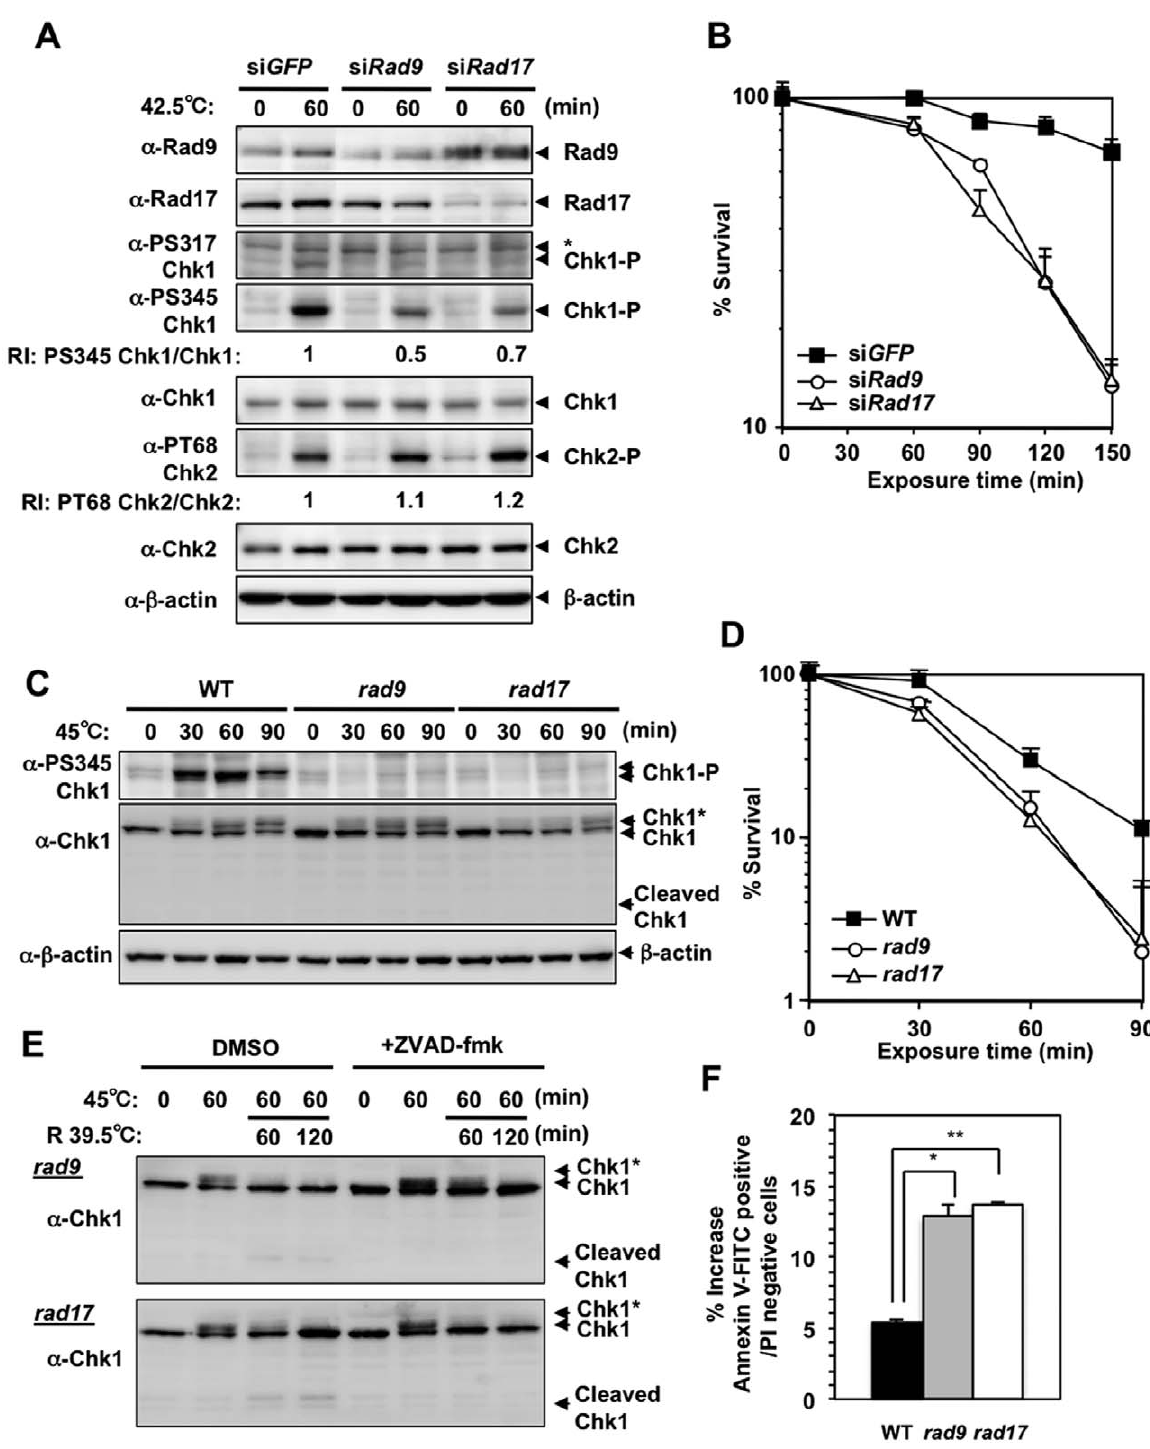
Figure 2. Rad9- or Rad17-deficiency inhibited heat-induced Chk1 phosphorylation at Ser345 and enhanced heat cytotoxicity. A. Western blot. HeLa cells were transfected with siRNA for GFP, Rad9 or Rad17 and cultured at 42.5 u C for 60 minutes. Non-specific bands were indicated as *. RI: relative intensity compared to the sample of si GFP and 42.5 u C for 60 minutes. B. Clonogenic survival. HeLa cells were transfected with siRNA for GFP, Rad9 or Rad17 and cultured at 42.5 u C for the indicated time. C. Western blot. Wild-type, Rad9 - and Rad17- deficient DT40 cells (WT, rad9 or rad17 ) were cultured at 45 u C for the indicated time. D. Clonogenic survival. WT, rad9 and rad17 DT40 cells were cultured at 45 u C for the indicated time. E. Western blot. The rad9 and rad17 DT40 cells were cultured at 45 u C for 60 minutes and at 39.5 u C for the indicated time in the presence of DMSO or caspase inhibitor (50 m M ZVAD-fmk). F. The induction of early apoptotic cells by heat. Early apoptotic cells were detected as annexin V-FITC- positive, propidium iodide (PI)-negative population. WT, rad9 and rad17 DT40 cells were cultured at 45 u C for 60 minutes and at 39.5 u C for 60 minutes, and the increase in early apoptotic cells induced by these treatment is shown. * p =0.0016, ** p =0.0002 (Student’s t test).